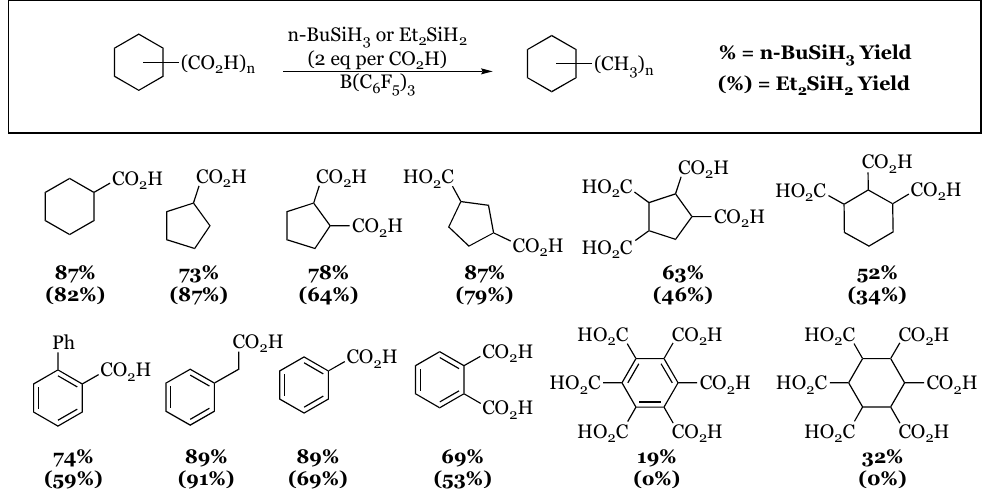
Figure 24. Reduction of mono-, di-, tri-, tetra-, and hexacarboxylic acids to methyl groups. * Use of n -butylsilane resulted in a 19% and 32% yield of the desired product, respectively.